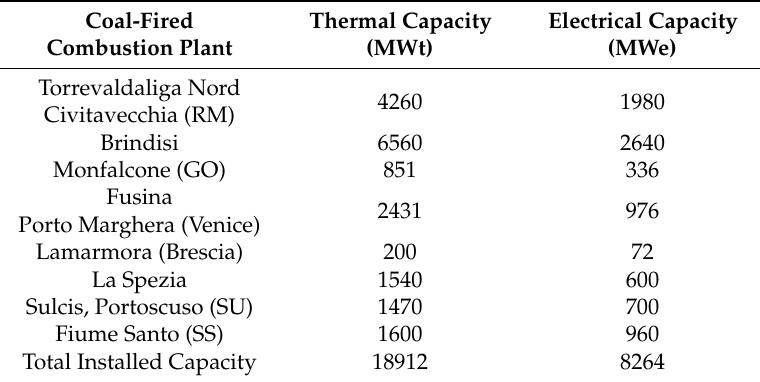
Table 2. Existing Italian coal-fired combustion plants capacity [15].